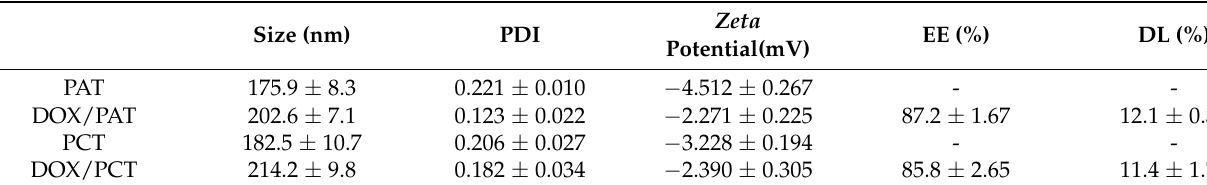
Table 1. Characterization of blank and DOX-loaded PCT and PAT micelles. Data were expressed as mean ± SD ( n = 3).